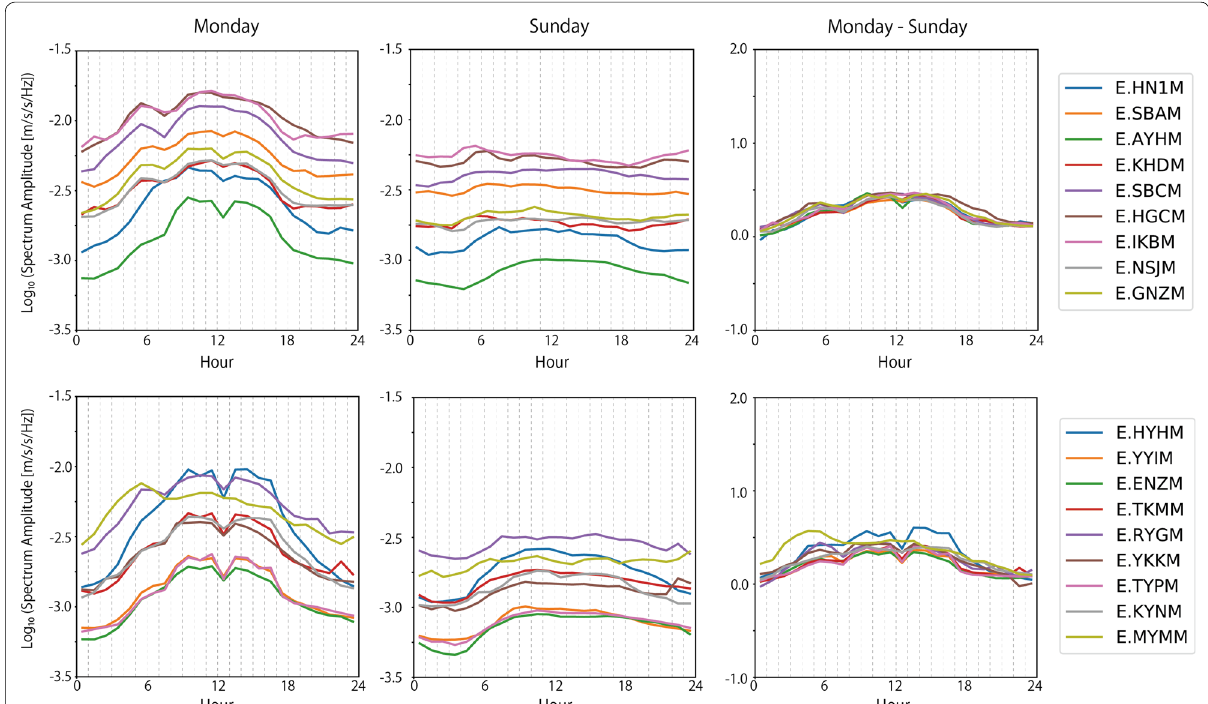
Fig. 5 Noise level at 4 Hz on Monday and Sunday. (Left) on Monday. (Middle) on Sunday. (Right) difference between the noise levels on Monday and